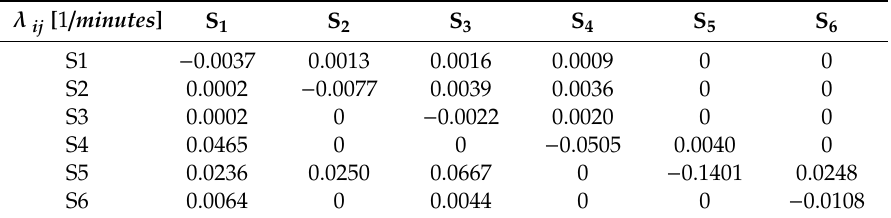
Table 9. The transition intensity matrix of the process studied.